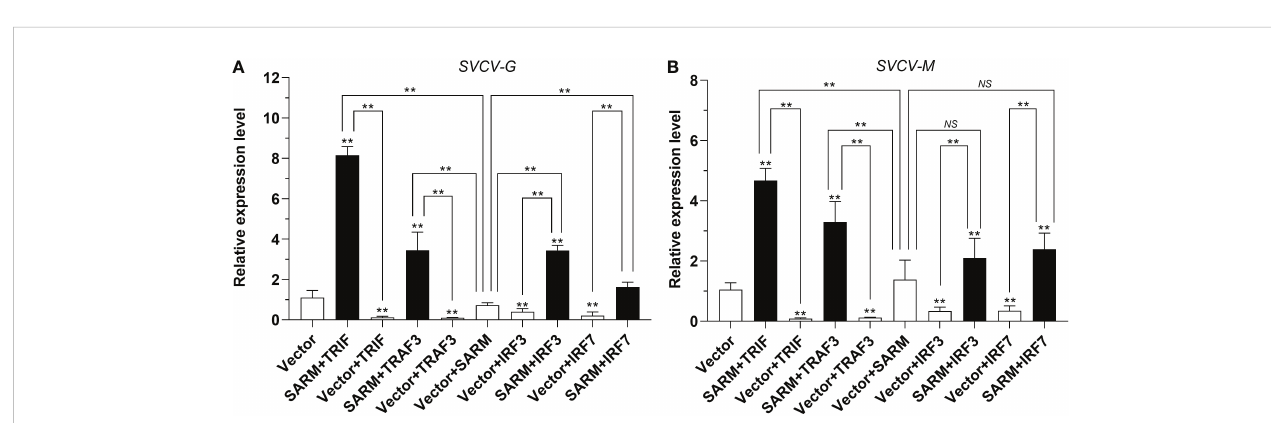
FIGURE 11 Antiviral effects of Lc -SARM co-expressed with Lc -TRIF, Lc -TRAF3, Lc -IRF3, and Lc -IRF7. EPC cells in 6-well plates (2 × 10 6 cells/well) were co- transfected with 2.5 m g of pcDNA3.1-SARM and 2.5 m g of pcDNA3.1-TRIF, pcDNA3.1-TRAF3, pcDNA3.1-IRF3, or pcDNA3.1-IRF7 alone or in a combination of two, with the total amount of transfected plasmids balanced with the pcDNA3.1 empty vector. At 24 hpt, the cells were infected with SVCV at an MOI of 1, the cells were then collected at 24 h post-infection for total RNA extraction, and the mRNA expression levels of SVCV-G (A) and SVCV-M (B) were detected by qRT-PCR analysis, with normalizing to the expression of EPC b -actin using the 2 – DD Ct method. All data are obtained from three individual experiments, with bars representing the SE. * P < 0.05; ** P < 0.01; NS, not signi fi